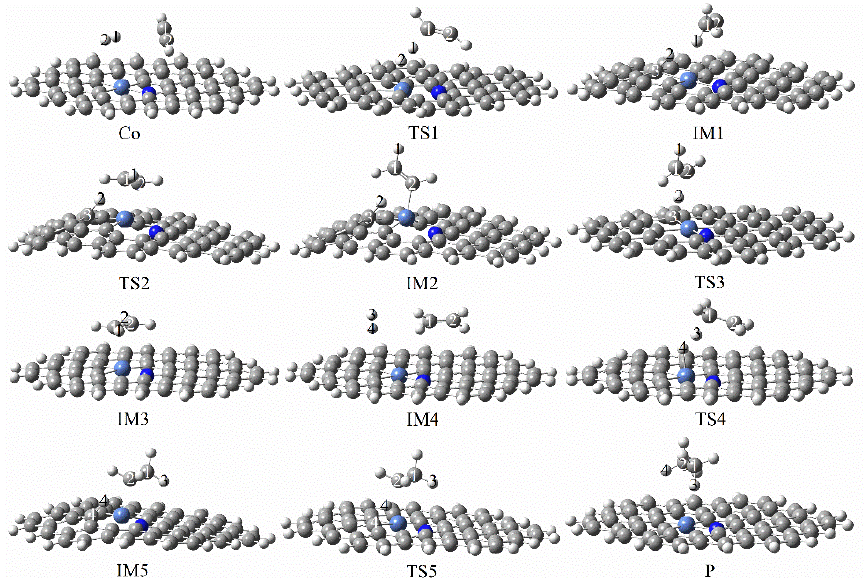
Figure 5. Optimal reaction pathway for acetylene hydrogenation catalyzed by graphene-NiN 1 catalyst.